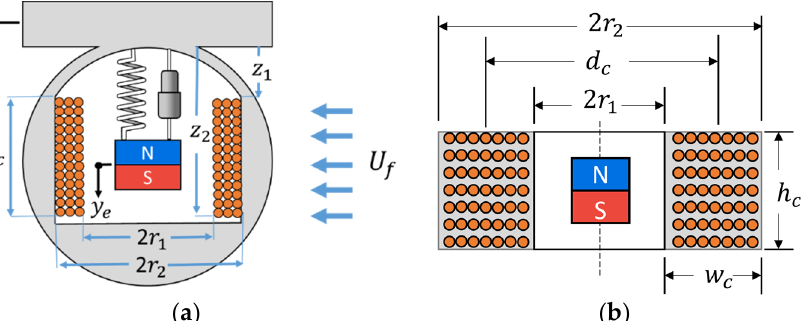
Figure 4. Electromagnetic energy harvester coil configuration: ( a ) the coil location and relative movement of the permanent magnet; ( b ) geometrical dimensions of a multi-layer coil.